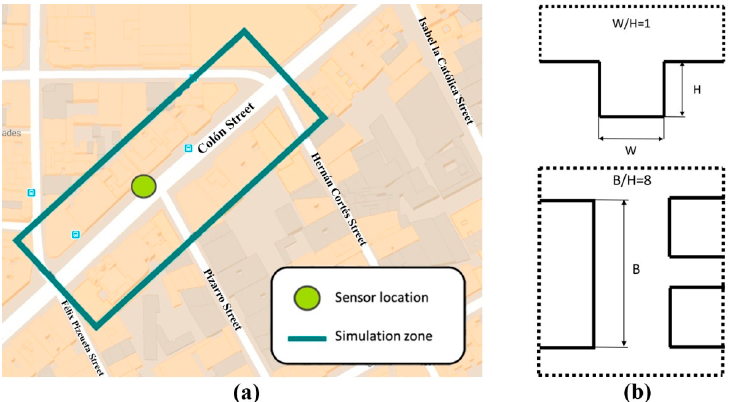
Figure 1. ( a ) Limits of the urban canyon studied in this paper; ( b ) vertical and horizontal schematics of the urban canyon analyzed in this